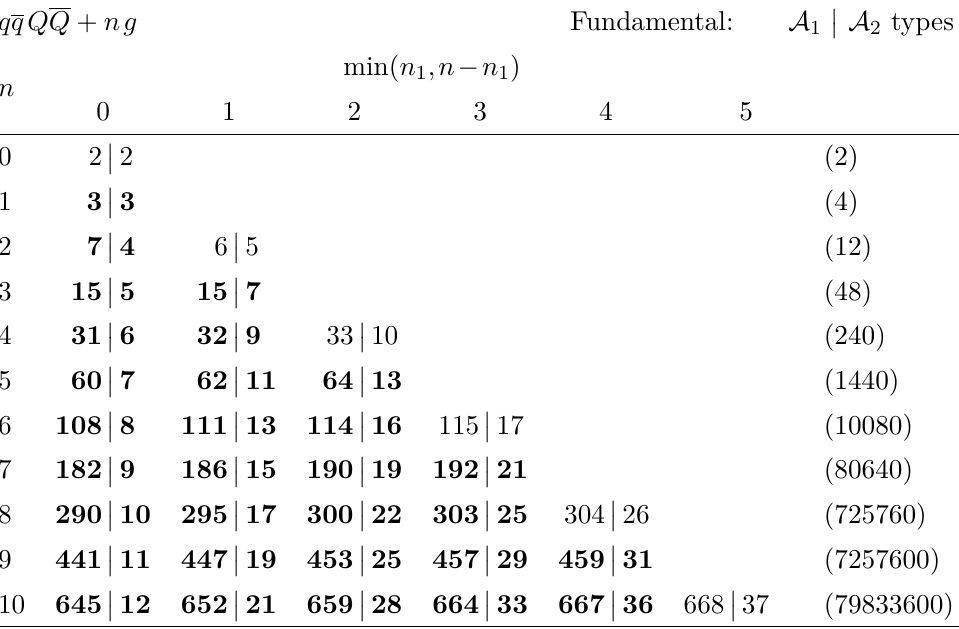
Table 4 . Number of non-zero elements in a single row of the colour matrix for qq QQ + n g (distinct flavours) up to NLC accuracy, O ( N n ) , in the fundamental basis. The various columns c min( n ) correspond to the smallest number of gluons of the two partitions n 1 , n − n 1 defined in eq. (2.33). Within a column, the number before (after) the vertical bar correspond to a dual amplitude of type A ( A ), see eq. (2.33). The numbers between brackets in the final column 1 2 denote the total number of columns in the colour matrix. In bold are marked those numbers which appear twice in the mirrored